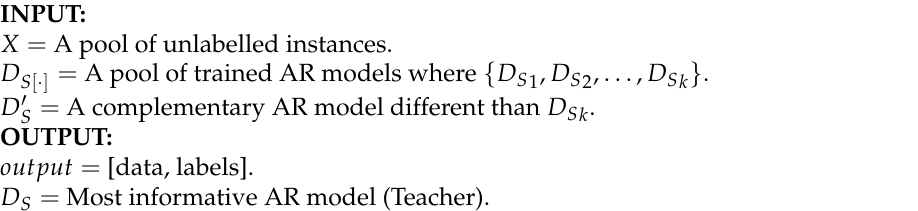
Algorithm 7 AL phase as depicted along steps 7–9 from the general representation of TL-FmRADLs’ architecture at Figure 1.